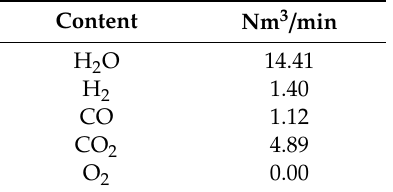
Table 3. Average o ff -gas analysis in campaigns (Nm 3 / min).